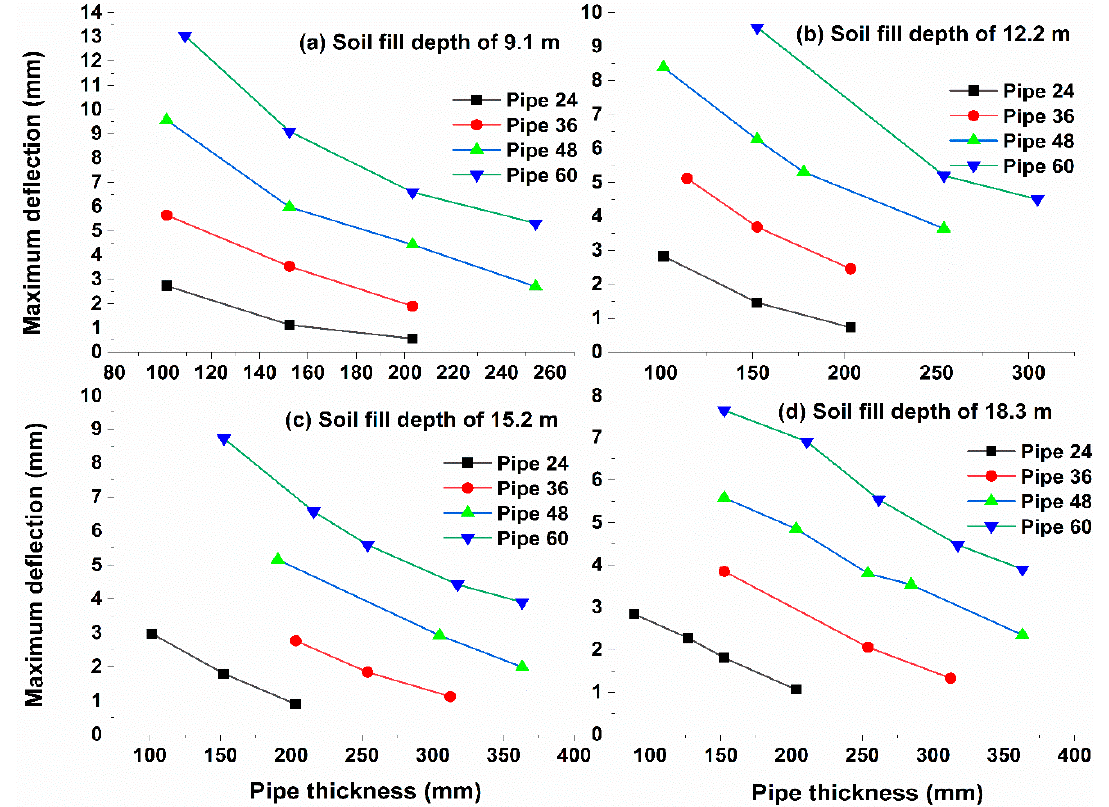
Figure 6. Maximum deflection versus reinforced concrete pipe thickness for various soil fill depths.